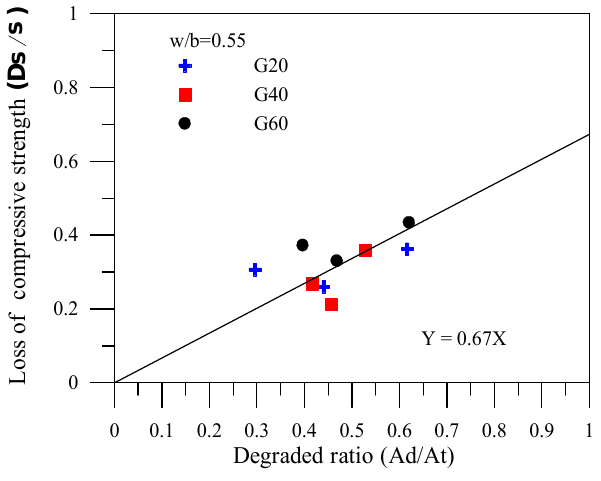
Figure 8. Correlation between the degradation area and the compressive strength loss for the specimens with